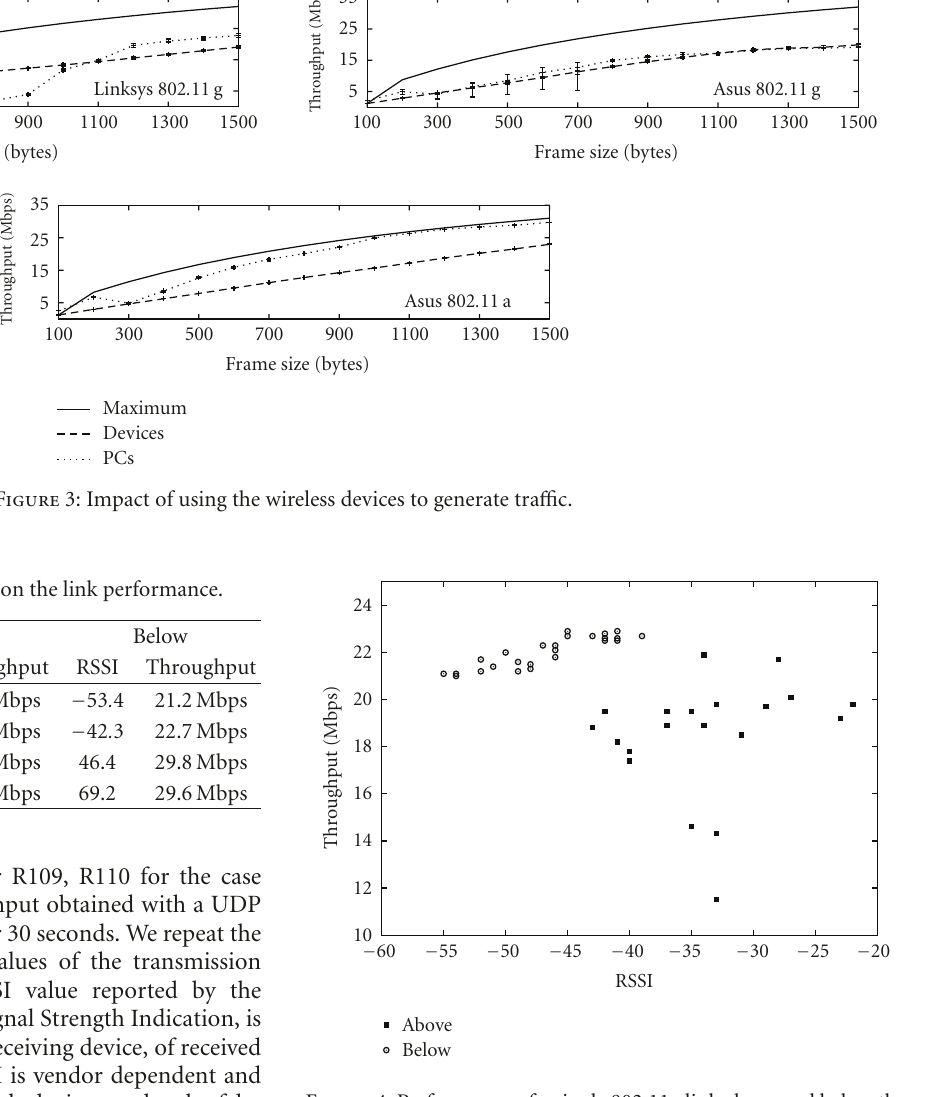
Figure 4: Performance of a single 802.11g link above and below the false